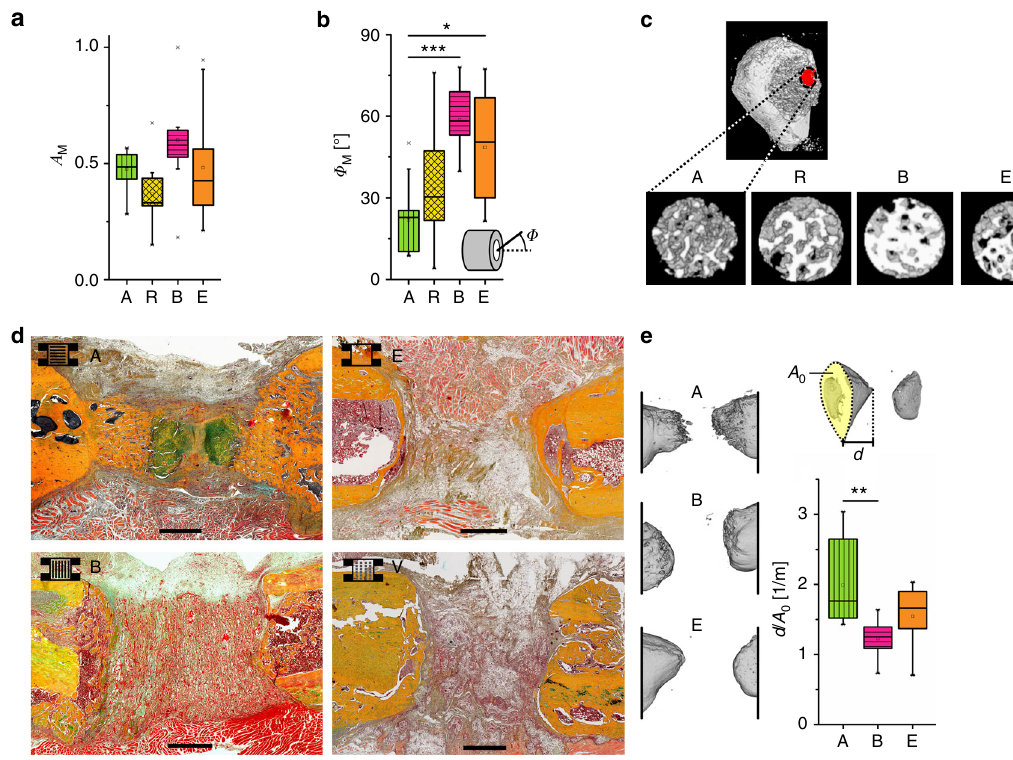
Fig. 8 Scaffold-induced endochondral ossi fi cation forms an aligned network of mineralized matrix supporting directional bone regeneration. a Quanti fi cation of the structural anisotropy A M in the mineralized matrix close to the mineralization front between non-mineralized and mineralized matrix derived from 3D reconstructed in vitro µ -CT data. Both the proximal and the distal mineralization front were analyzed resulting in two values per sample. Boxplot shows a non-signi fi cant trend for a reduced anisotropy A M in scaffolds R compared with the other scaffold groups (A, B), 3 weeks post-op. b Analysis of the primary direction of anisotropy of the mineralized matrix. Boxplot shows the angle Φ M relative to the bone axis. Signi fi cant differences were found between scaffold A and both, scaffold B and the empty control group while the data points of group R showed a strong scattering. c 3D µ -CT reconstruction of the mineralized matrix in the VOIs used for quanti fi cation in a and b . The red dot indicates the position of the VOI at the growth tip of the mineralized callus. d Movat ’ s pentachrome staining showing guided EO along the scaffold pore orientation for A and no ingrowth for B and V compared with the formation of a bony shell for empty controls E, 6 weeks post-op. e 3D µ -CT reconstruction of the resulting bone geometry for A, B, and E, 6 weeks post-op. Boxplot shows the ratio d / A 0 representing the length of the callus in the direction of the bone axis d divided by the cross-sectional area A 0 at the osteotomy plane as a measure of the directionality of mineralization across the bone defect. All boxplots show the median, 25th, and 75th percentile values (horizontal bar, bottom, and top bounds of the box), whiskers indicate 1.5-fold IQR, open squares indicate means, crosses represent max./min. values. Statistical signi fi cance via Mann – Whitney test (two-sided) with Bonferroni correction, n = 5 – 6 animals ( a , b ) and 7 – 8 ( e ) per group. * p < 0.05, ** p < 0.01, *** p < 0.001. Scale bars for c 200 µ m, for d 1